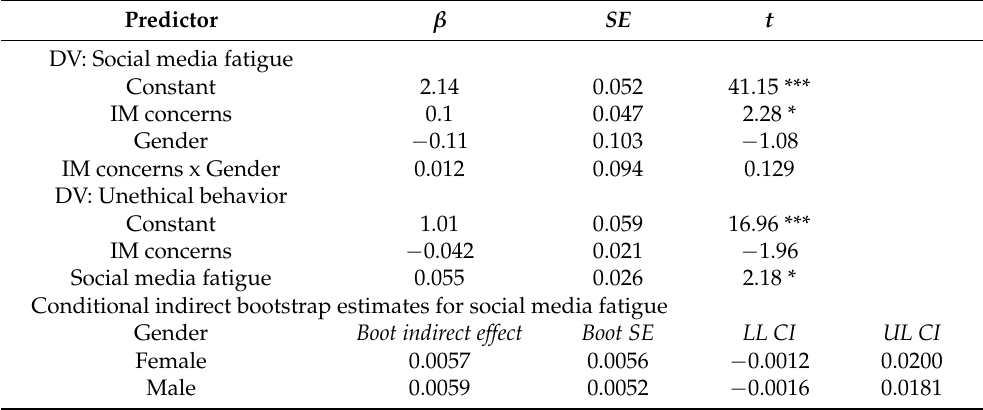
Table 5. Results of the moderated mediation